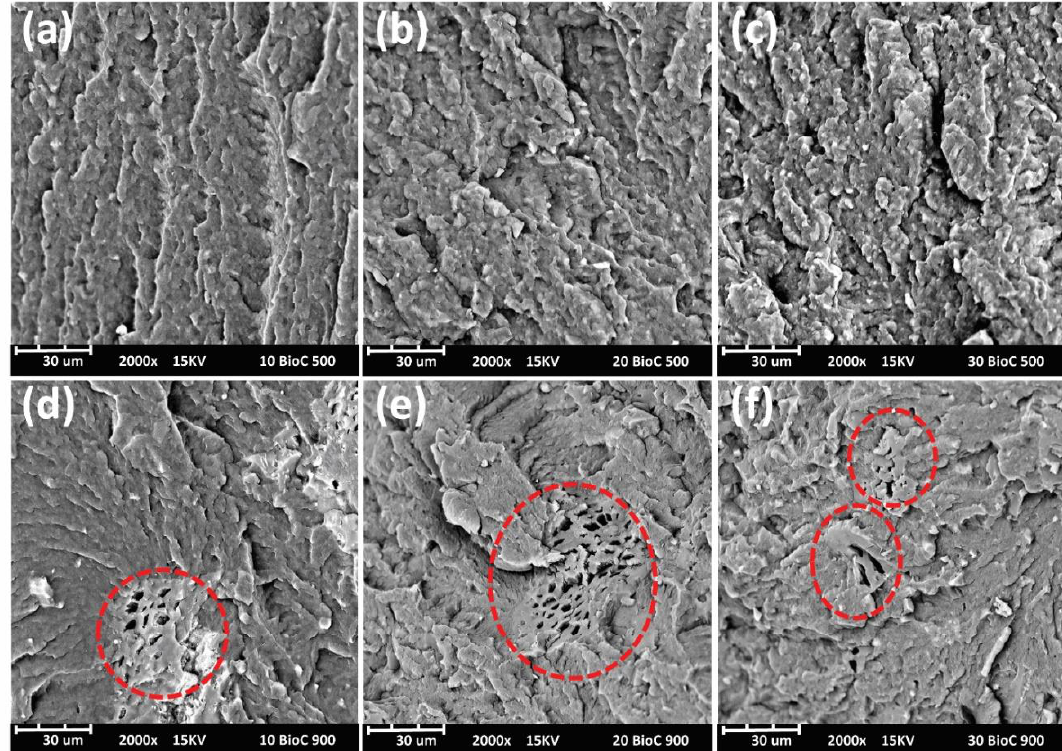
Figure 11. SEM images of the cryo-fractured morphology of BioC/PA66 composites with different biocarbon content. ( a ) 10 wt%, ( b ) 20 wt%, and ( c ) 30 wt% of BioC500/PA66, and ( d ) 10 wt%, ( e ) 20 wt%, and ( f ) 30 wt% of BioC900/PA66 biocomposites.